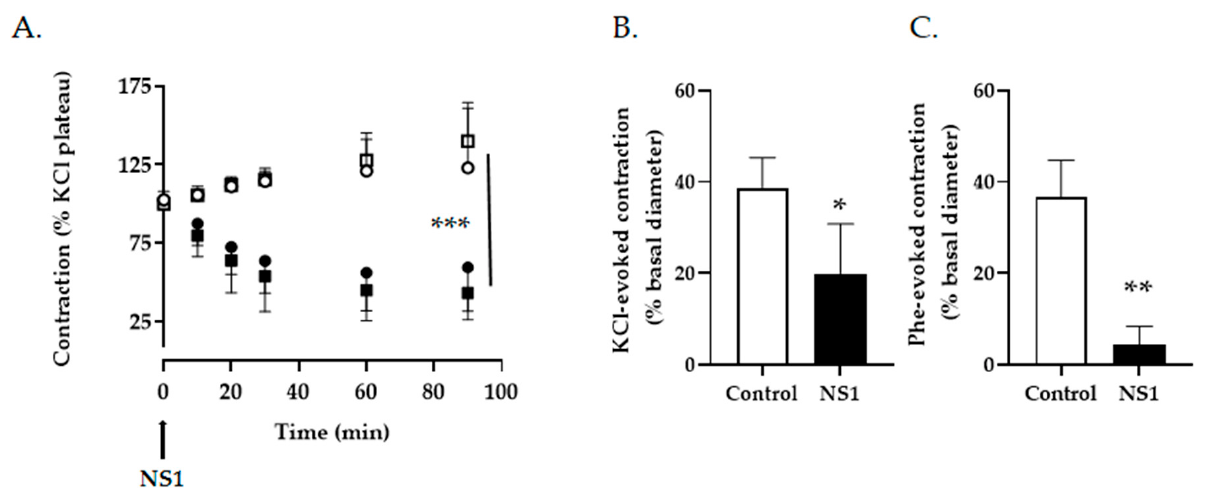
Figure 4. NS1 inhibition of vascular contraction. ( A ) Mice aortic rings with (circles) or without endothelium (squares) were pre-constricted in the presence of high KCl solution (50 mM) then exposed to 10 µ M NS1 (black symbols) or solvent (open symbols) at the plateau phase of the contraction. Vascular tone was measured during 90 min after addition of NS1 and expressed as percent of the contractile response at time 0. Mean ± SEM of three to five independent experiments, two-way anova, *** p < 0.001. ( B , C ) Micro-mesenteric arteries (ext. diam: 140 ± 15 µ m) were contracted in the presence of high KCl (50 mM) or Phenylephrine (10 µ M) before and after incubation with NS1 (10 µ M) for 2 h. Mean ± SEM of 3 independent experiments, paired t-test, * p < 0.05, ** p < 0.01. MTT assays were performed to ascertain that the relaxation process did not result from smooth muscle cell death or altered energetic metabolism. When incubated for up to 2 h, NS1 only minimally affected A7r5 cell viability (Figure 5). Together, this suggests that NS1 would not hinder tissue perfusion and